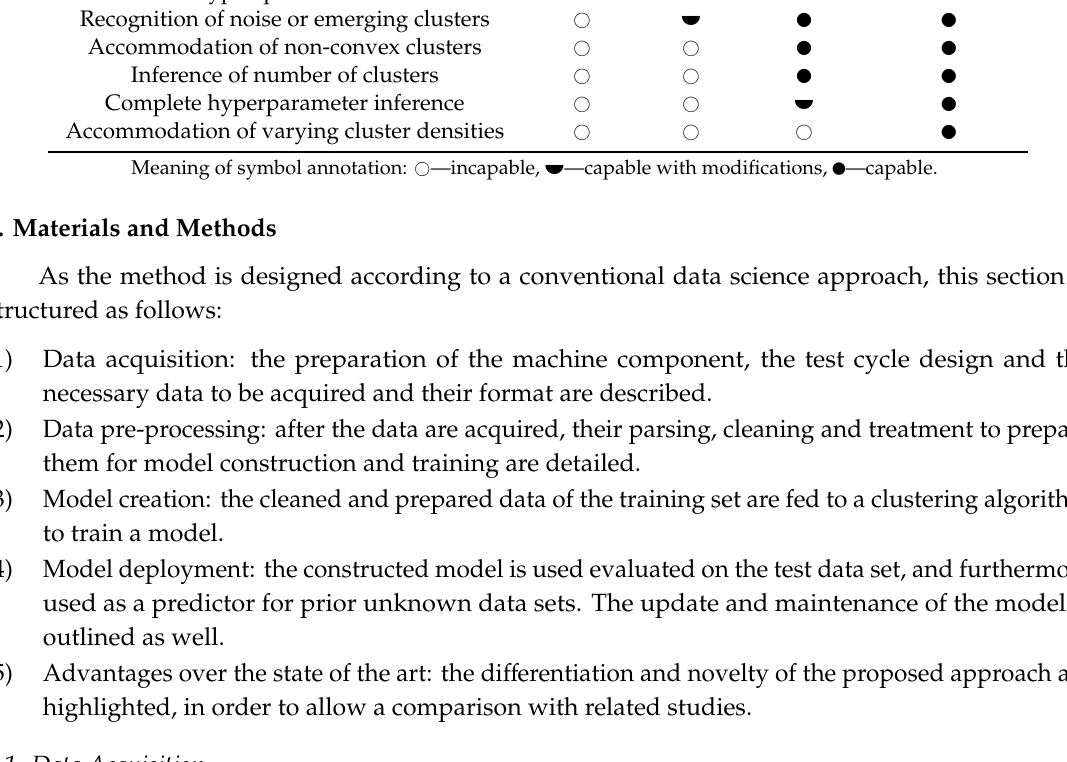
Table 1. Qualitative capability comparison of selected clustering algorithms. k-Means GMM